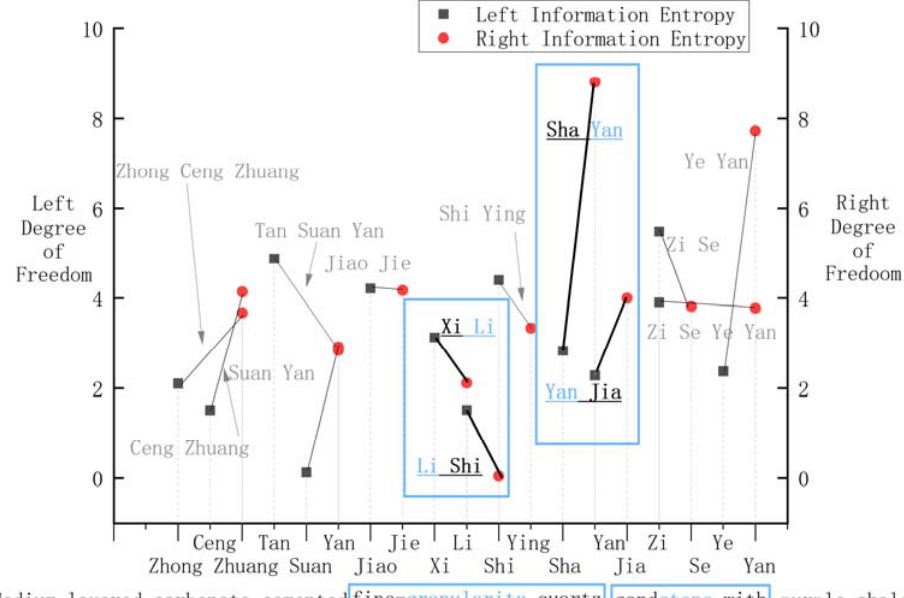
Figure 4. Logic visualization of intersecting conflict. Table 1. High-degree-of-freedom priority strategy based on information